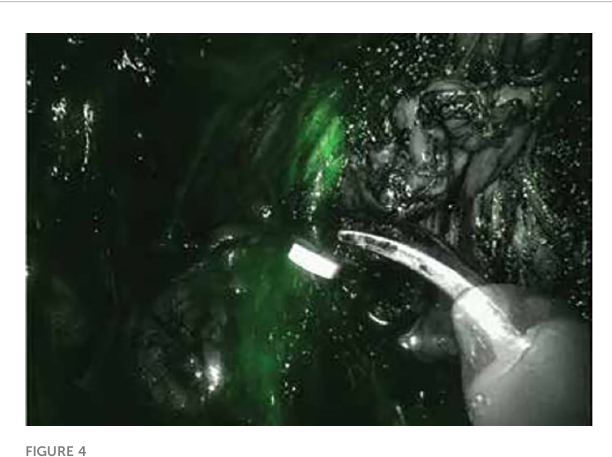
FIGURE 4 Prostate vascularization and neurovascular bundles by ICG. Reprinted with permission from Mangano et al. (80). Copyright © 2017 Wichtig Publishing.